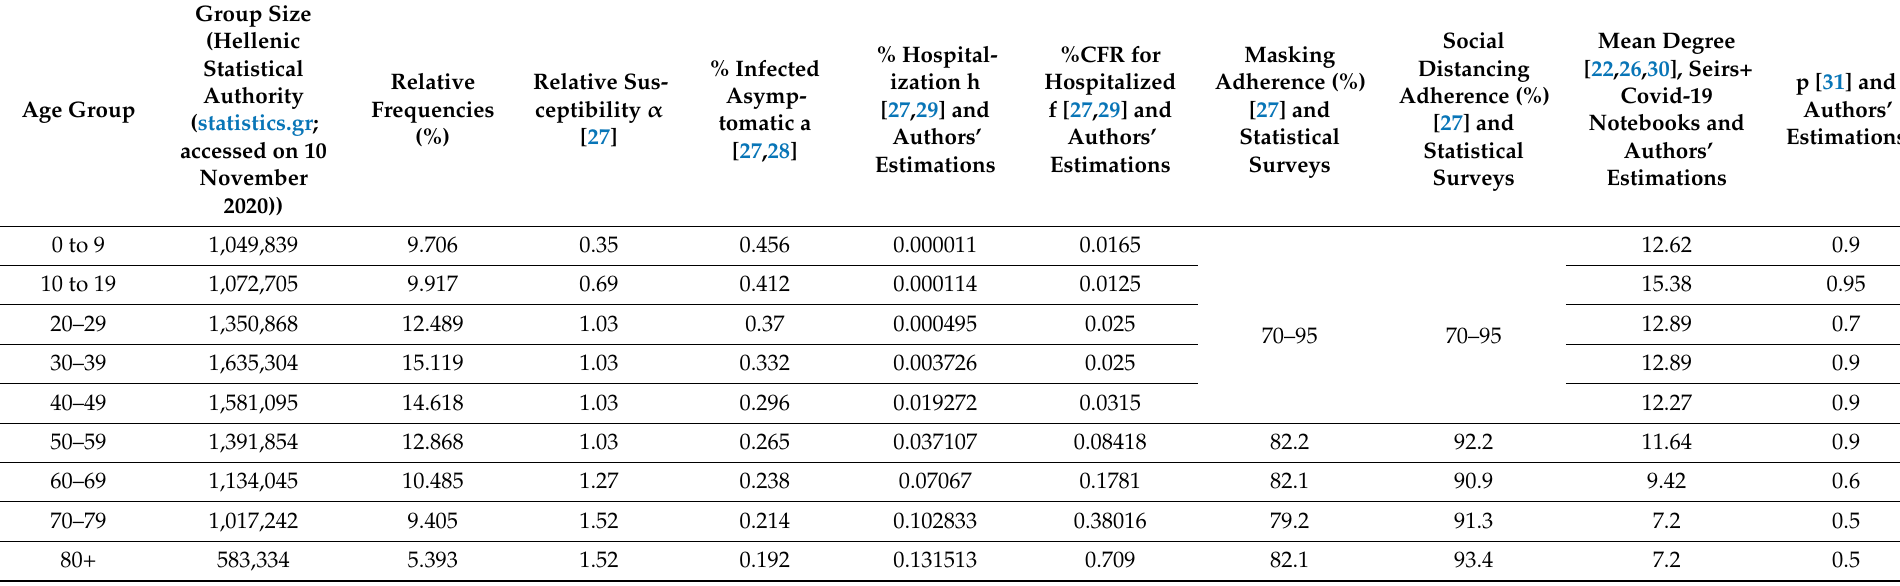
Table 3. Age-dependent parameters’ values used of the Phase 1 SEIR and Phase-2 SVEIR models used to assess COVID-19 transmission dynamics in